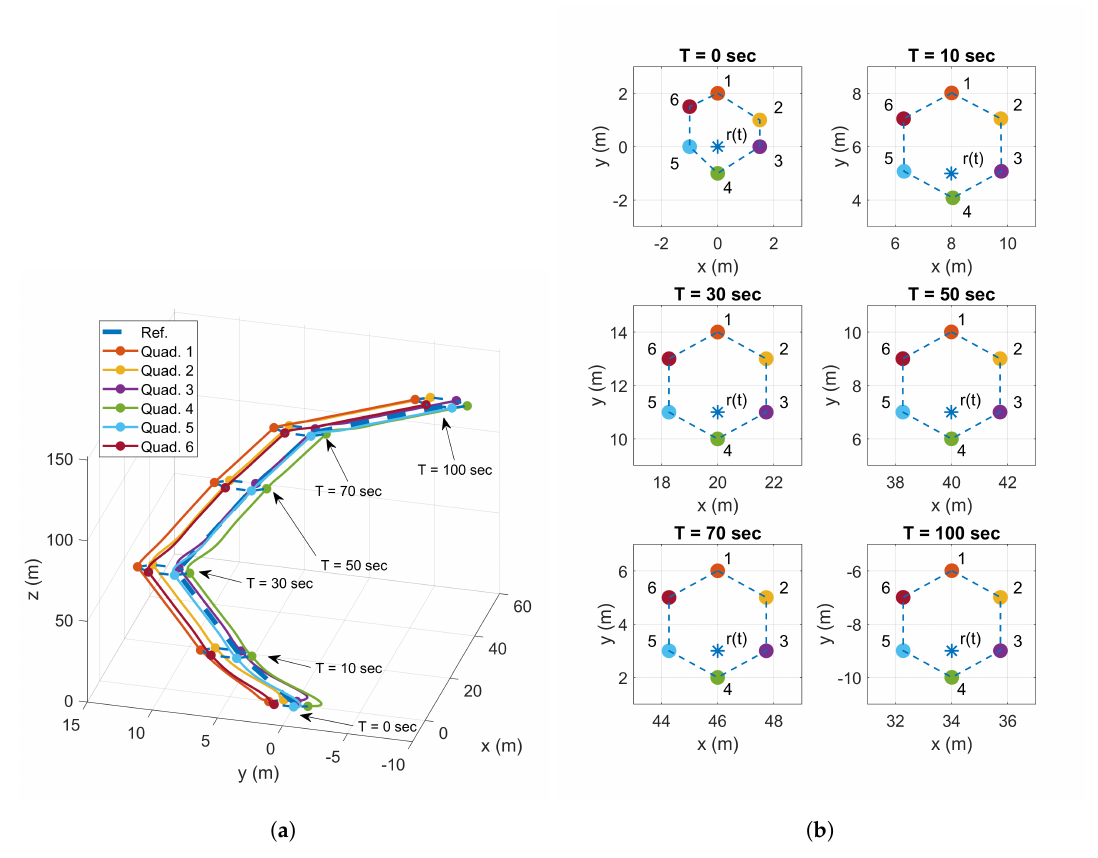
Figure 7. The illustration of multiple lines trajectory. ( a ) Formation flight of the six quadcopters with multiple line trajectories in three-dimensional space. ( b ) Position snapshots of the six quadcopters and multiple line trajectories projected into the xy -plane.